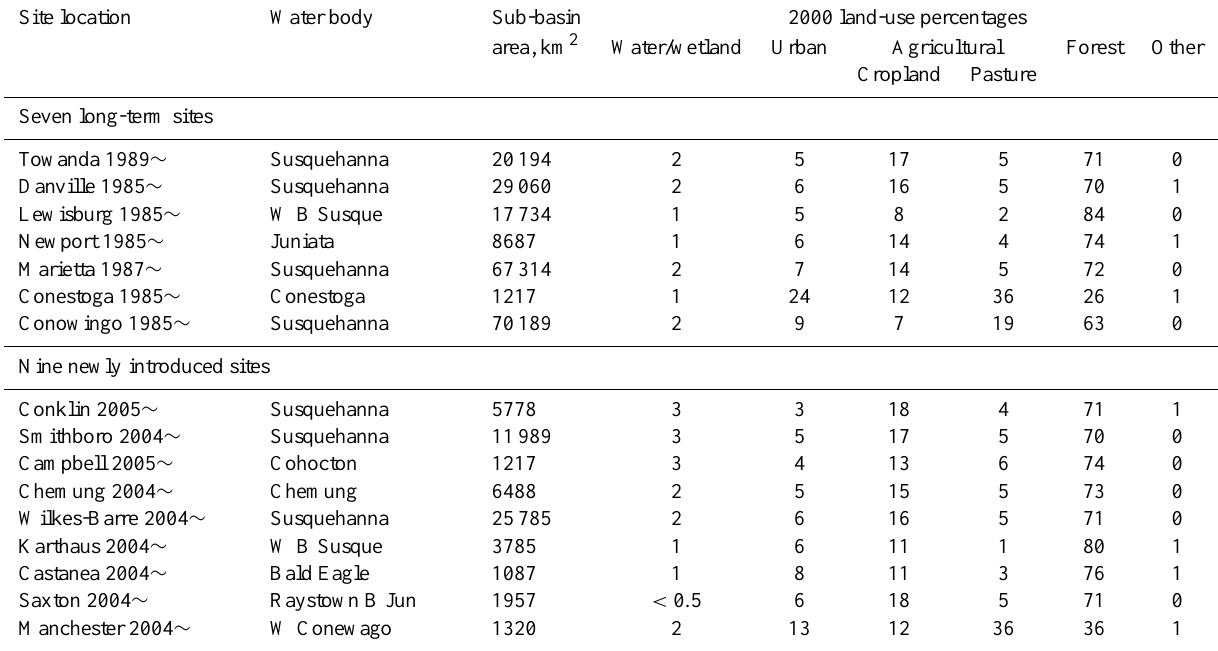
Table 3. Susquehanna River Basin Geographic Statistics for the USGS and SRBC nutrient monitoring sites (McGonigal, 2011; USGS, 2014). Abbreviations: W B Susque = West Branch Susquehanna, Bald Eagle = Bald Eagle Creek, Raystown B Jun = Raystown Branch Juniata, W Conewago = West Conewago